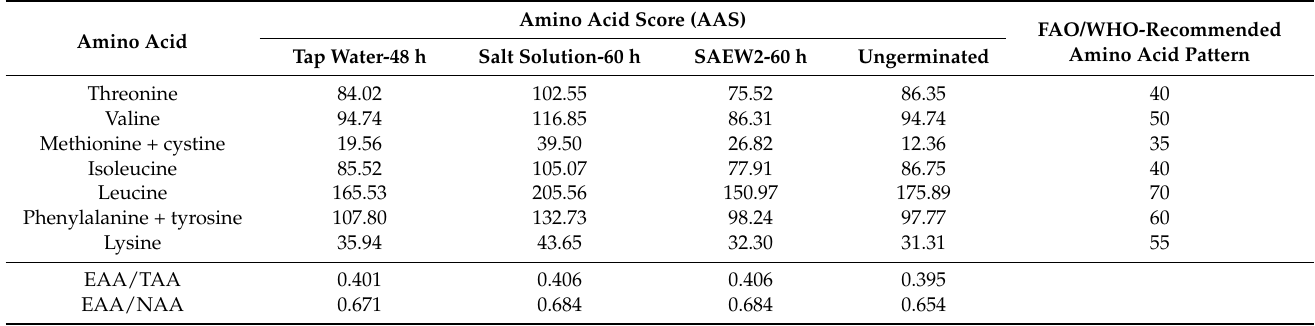
Table 5. Composition patterns and AAS of essential amino acids in foxtail millet protein 1